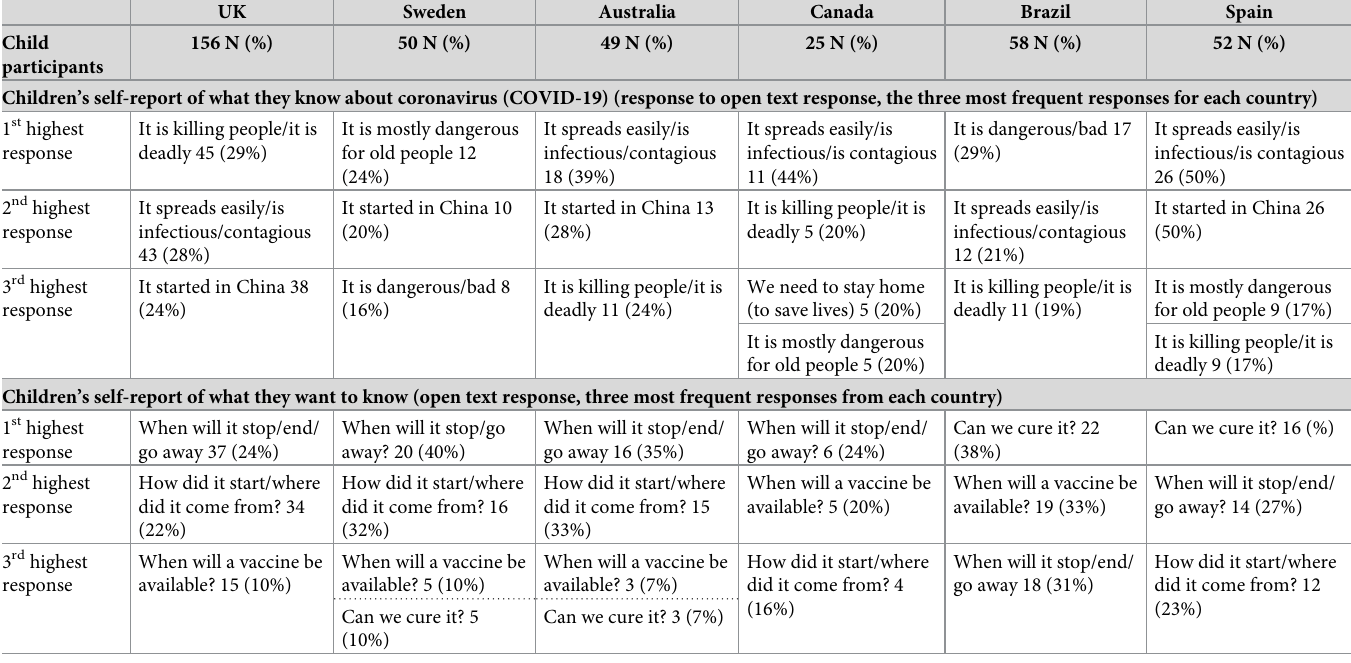
Table 9. Children’s self-report of their knowledge and information needs relating to